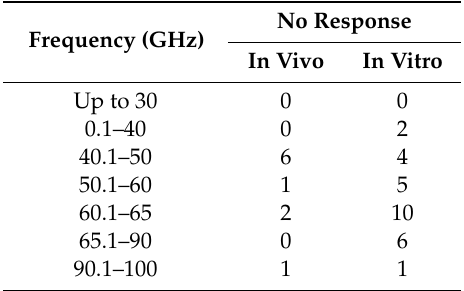
Table 3. Studies without